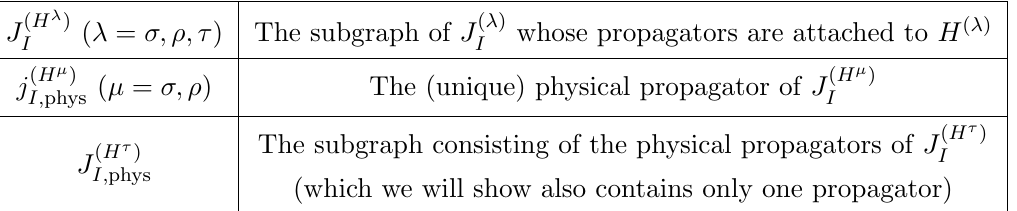
Table 5. Some notations in section